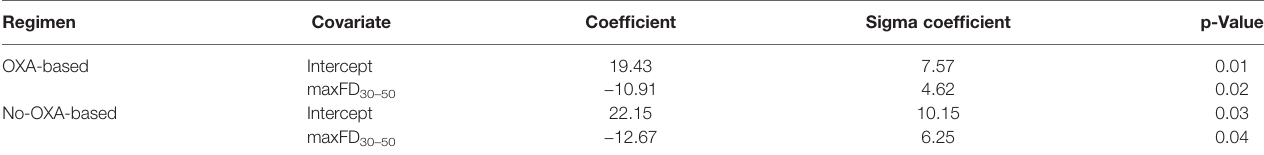
TABLE 2 | Covariates and coef fi cients of the linear logistic regression models elaborated to predict 5yDFS from the analysis of T2-w MR staging images. Regimen Covariate Coef fi cient OXA-based